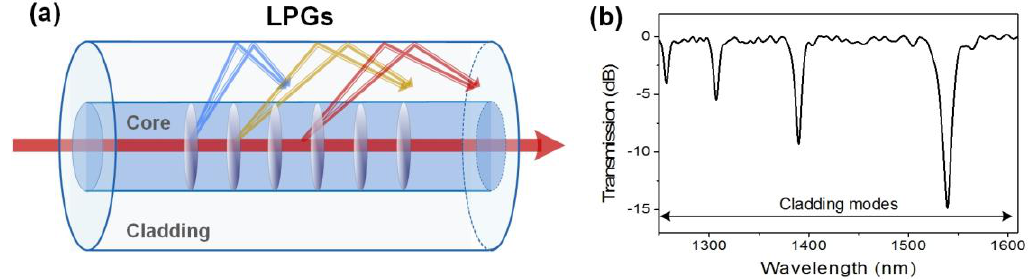
Figure 6. ( a ) Sketch of the light mode coupling in a long-period fiber grating (LPFG); and ( b ) transmitted amplitude spectrum of a 1 cm-long LPFG.